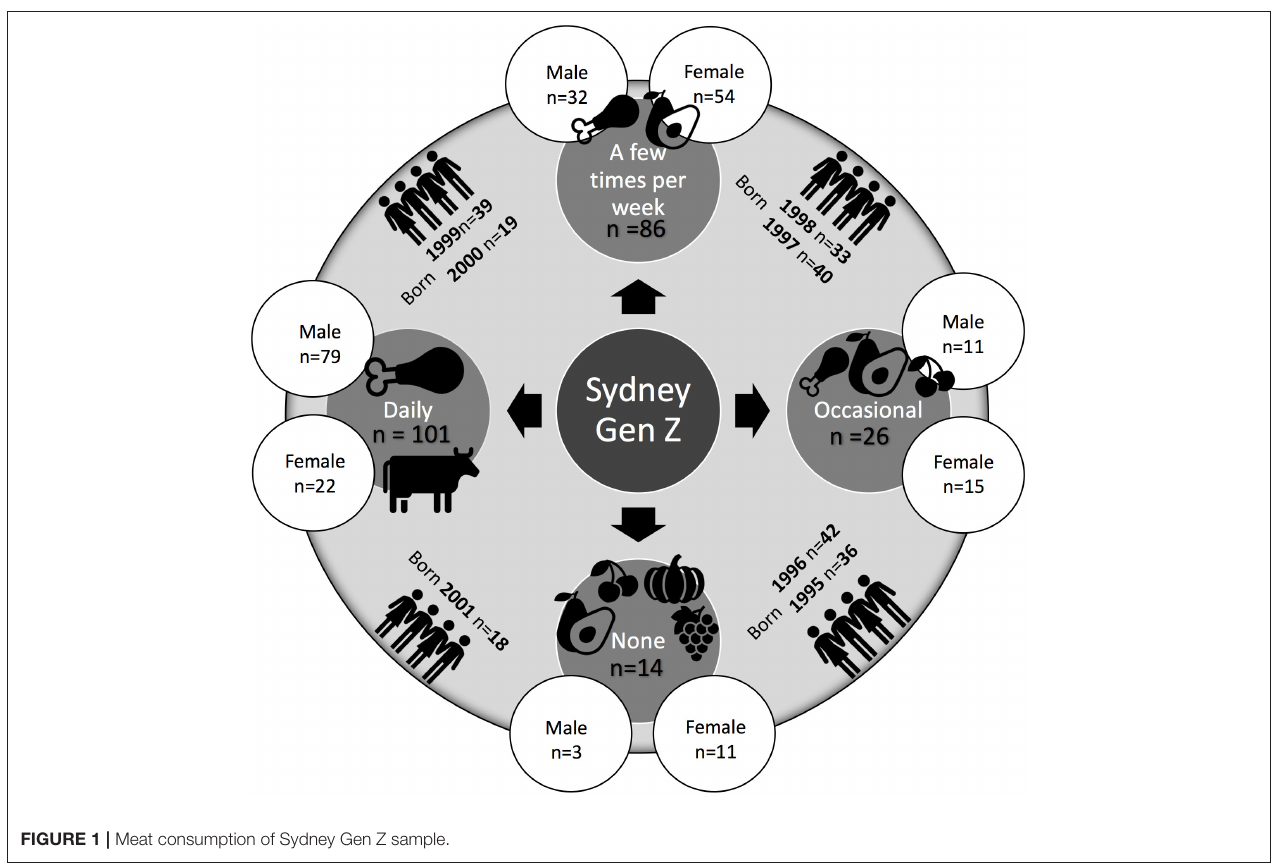
FIGURE 1 | Meat consumption of Sydney Gen Z sample.